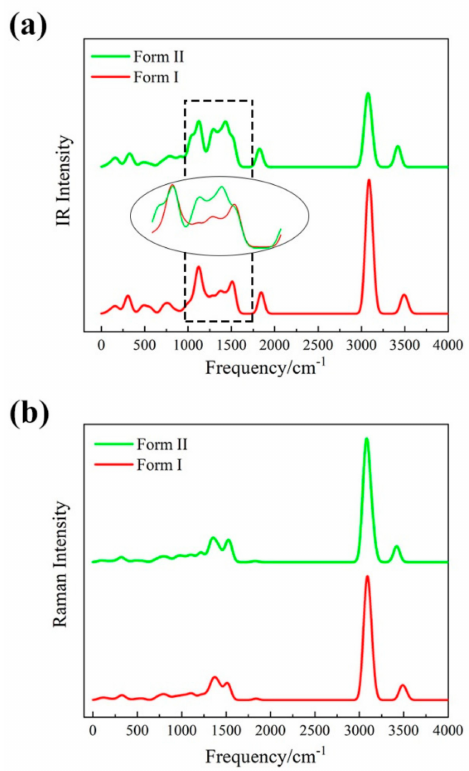
Figure 3. The IR ( a ) and Raman ( b ) spectra of β -lactam in form I (red curves) and form II (green curves) under standard atmospheric pressure (100 KPa). The inset in ( a ) shows the characteristic IR peaks for forms I and